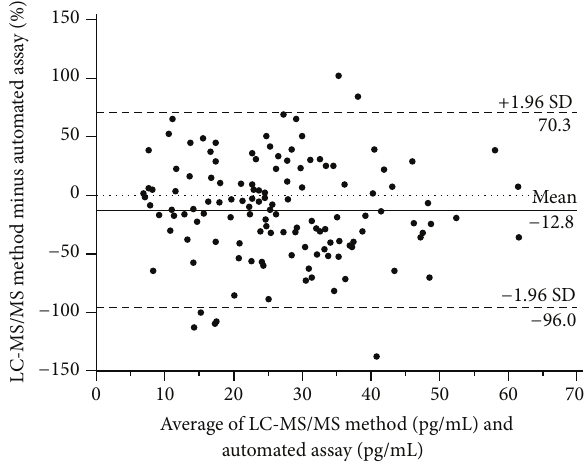
Figure 5: Bland-Altman plot showing the bias between the auto- mated method and the mean of the two methods on a percentage